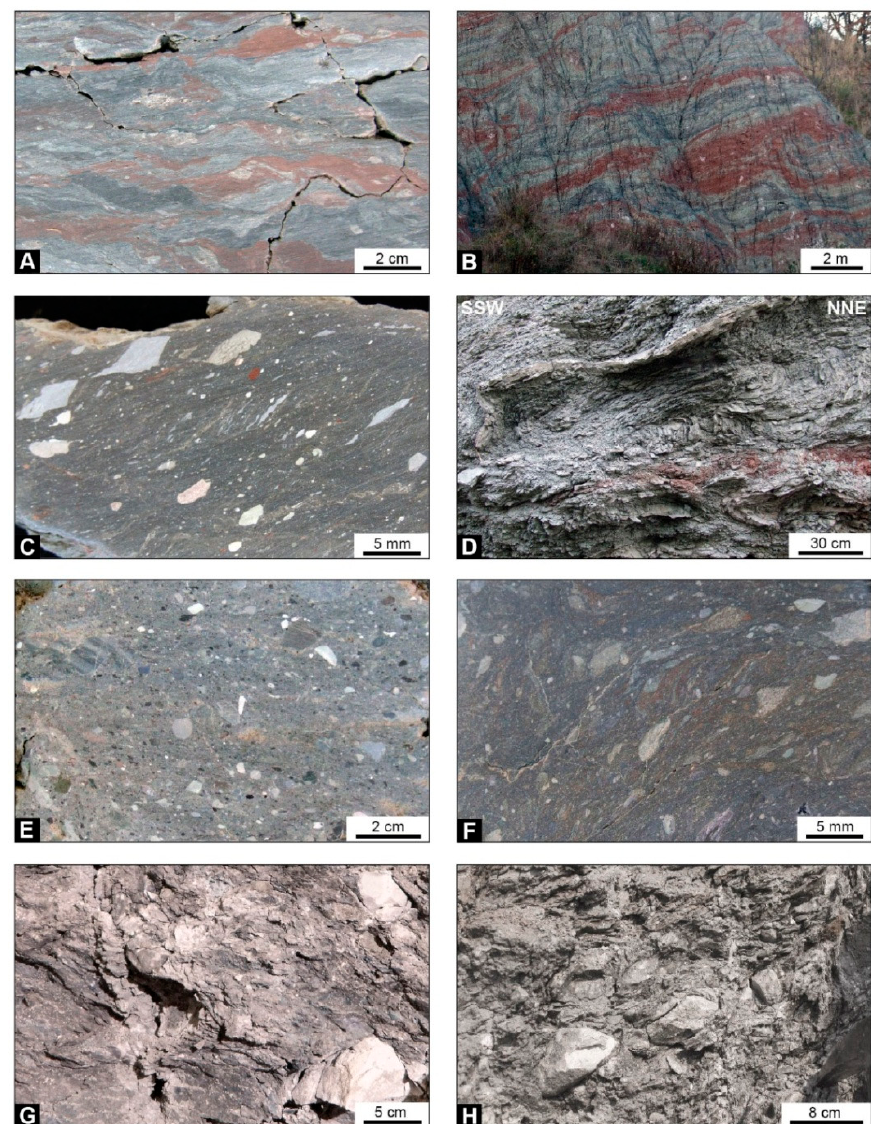
Figure 3. Close up view of the different hand-sample-to-meso-scale block-in-matrix fabrics of mélanges and broken formations studied. Broken formation (i.e., the Argille varicolori of the External Ligurian units): ( A ) asymmetrical brittle boudinage and pinch-and-swell structures of alternating varicolored shaly, clayey, and marly layers; ( B ) disharmonic-to-isoclinal and transposed folds with sub-horizontal axial surfaces aligned parallel to the tectonic layering and/or pseudo-bedding, which results in the development of pinch-and-swell structures and boudinage of shaly layers due to layer-parallel extension along the fold limbs. Tectonic mélange : ( C ) polished cut of the high-strain shear zone that shows millimeter-sized elongated asymmetric “exotic” clasts in a fine grained matrix. In the central part of the photograph, elongated clasts show a P-C fabric; ( D ) shear transposition and overprinting of the previously formed isoclinal folds of the broken formation that forms isolated fold hinges with axial surfaces aligned to planar northeast-verging shear zones and mesoscale thrust faults, resulting in the production of the tectonic mélange. Sedimentary mélange : ( E ) polished surface of hand sample showing the isotropic texture of the brecciated shaly matrix with irregular shaped blocks randomly distributed within the matrix; ( F ) polished surface of hand sample of the basal shear zone of the sedimentary mélange, showing the reorientation of elongated hard clasts to S-C fabric. Polygenetic mélange : ( G – H ) sub-angular to angular, and tabular clasts and blocks, centimeter- to decimeter in size, embedded in a brecciated shaly matrix, and gently reoriented by a scaly fabric related to tectonic deformation.